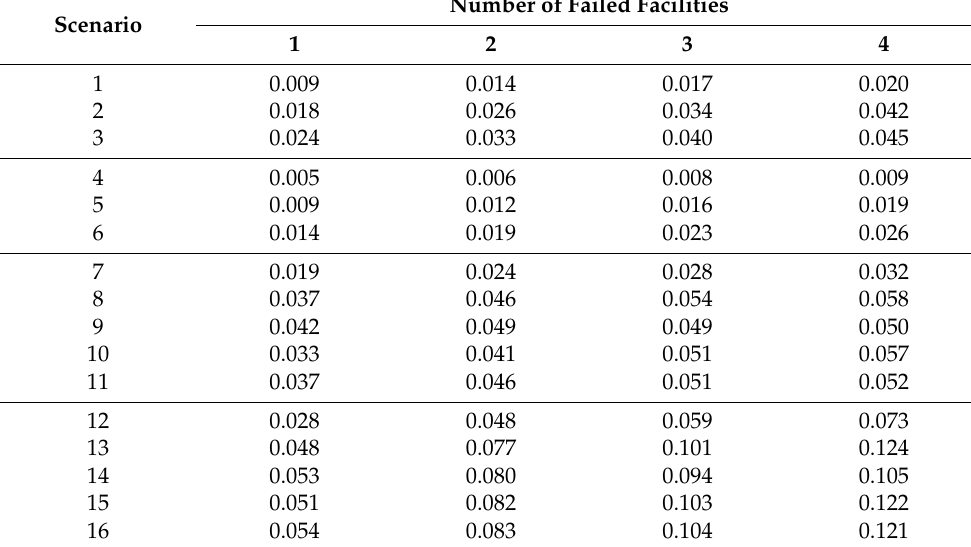
Table 3. Results of EoRE.